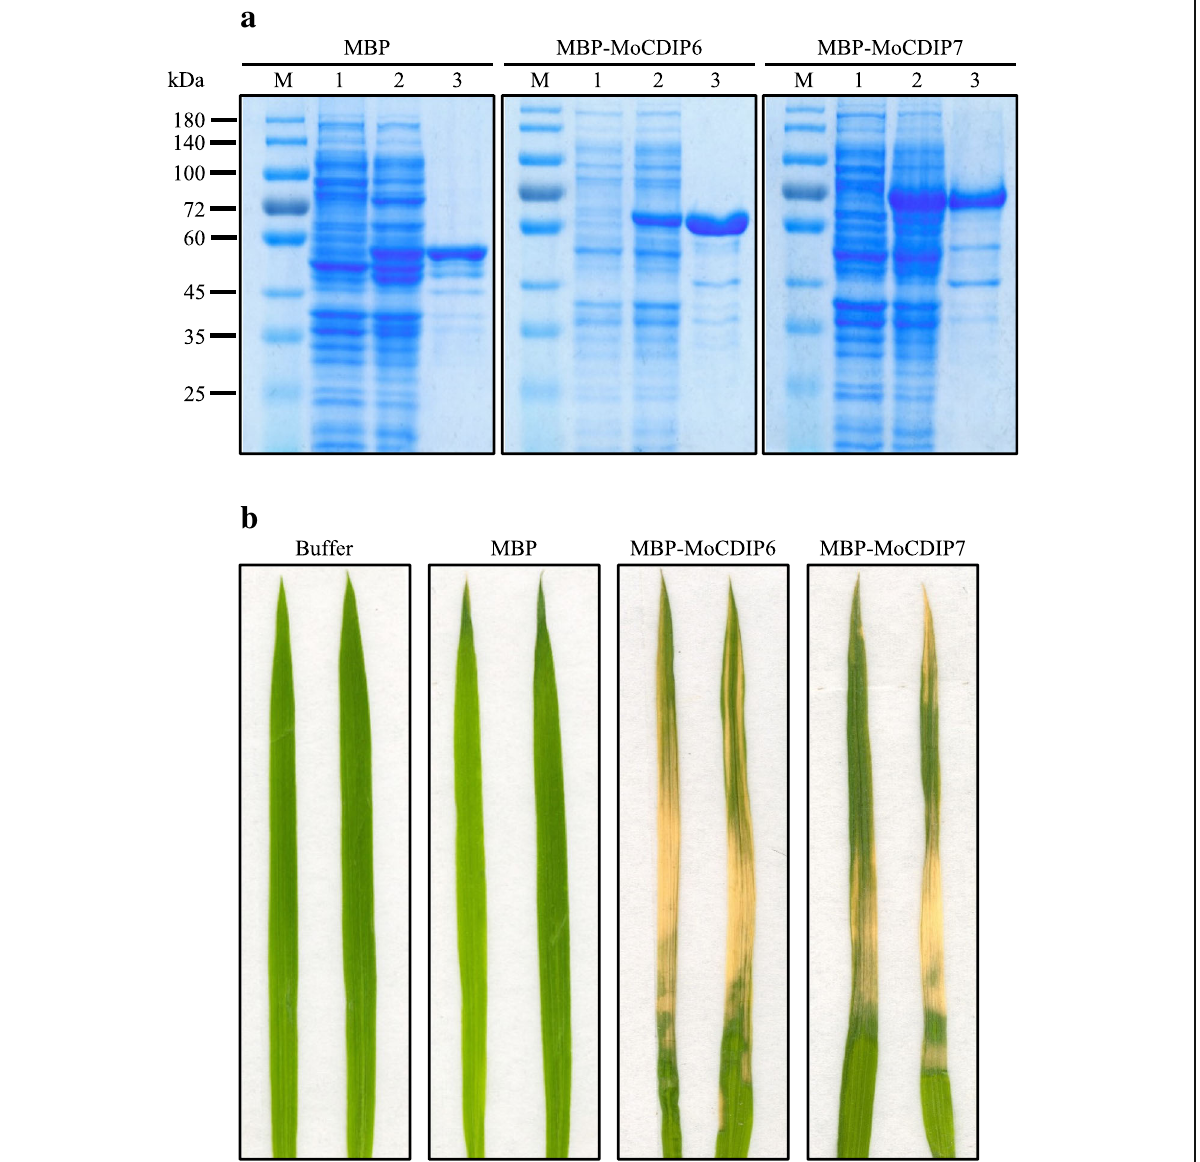
Fig. 4 Recombinant MoCDIP6 and MoCDIP7 caused necrosis on leaves of rice seedlings. a Heterologous expression and purification of MBP, MBP-MoCDIP6, and MBP-MoCDIP7. M, protein molecular marker; 1, bacterial lysate before induction; 2, bacterial lysate after induction with IPTG; 3, purified MBP-tagged proteins. b Necrosis symptoms on leaves of Nipponbare rice seedlings sprayed with recombinant MoCDIP6 or MoCDIP7 (10 μ M). The leaves were photographed 2 days after spray of the